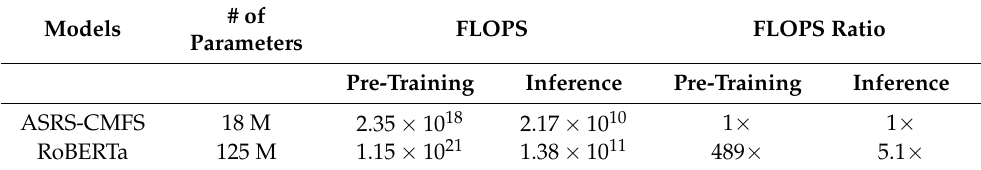
Table 12. Efficiency of the two models. # of Models FLOPS FLOPS Ratio Parameters Pre-Training